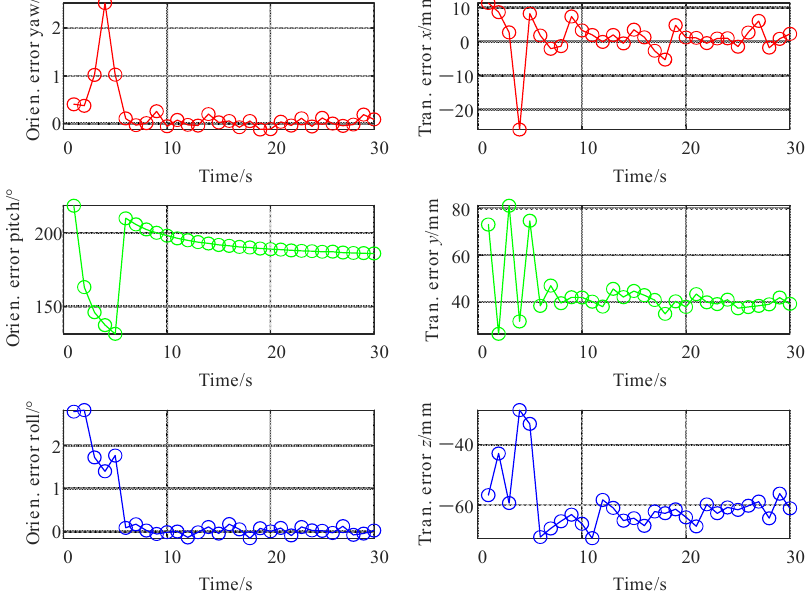
Figure 7. External parameters’ calibration error of IMU and LiDAR varies with time.